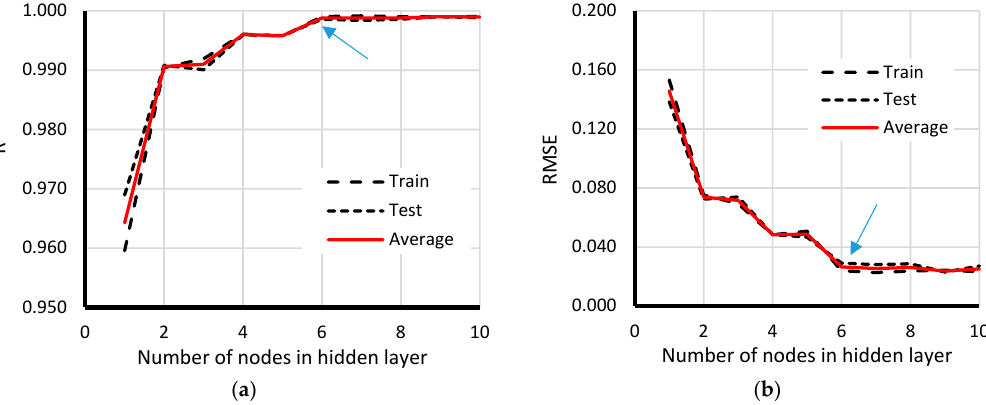
Figure 4. Multi-layer perceptron regressor (MLPr) neural network typical architecture.